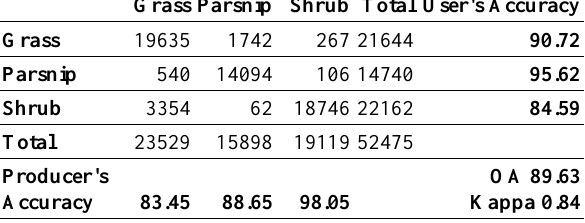
Table 2. Error matrix for accuracy assessment at Image Resolution 0.01 m.